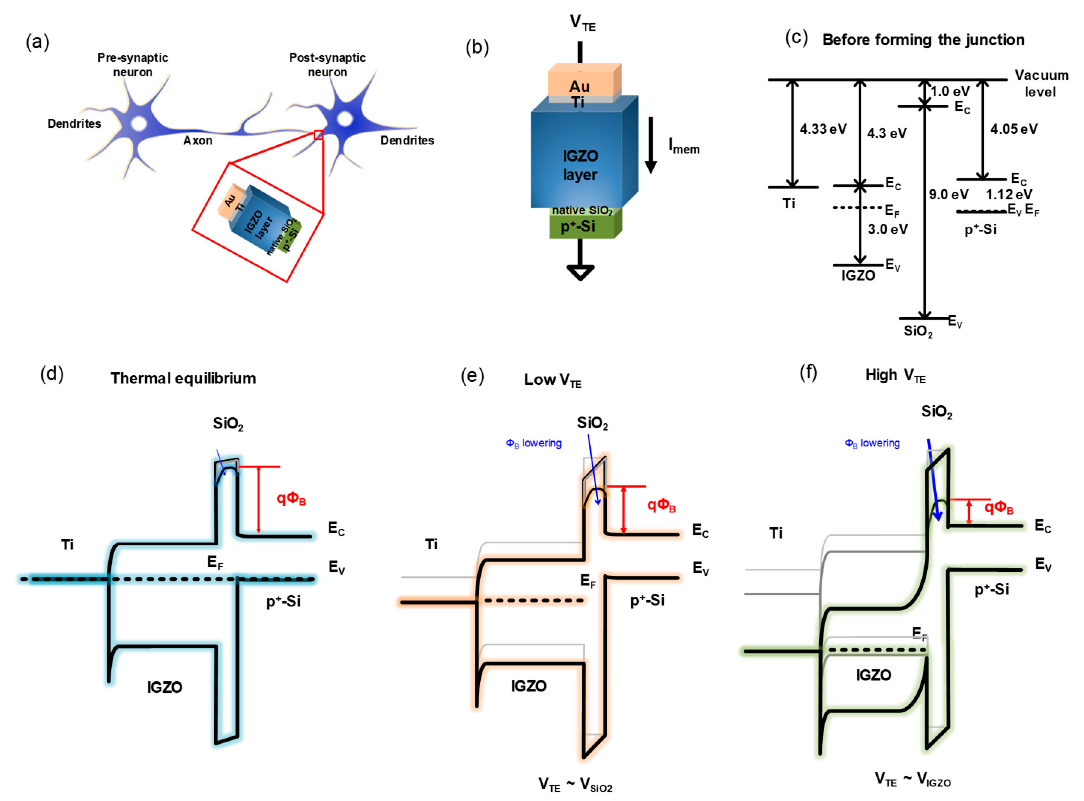
Figure 1. Schematic illustration of ( a ) the implementation of the synapse devices in bio-inspired neuromorphic computing systems and ( b ) the two-terminal Au / Ti / (amorphous indium-gallium-zinc-oxide) a-IGZO / SiO 2 / p + -Si memristors. Energy band diagram ( c ) before forming the junction, and under three conditions: ( d ) in a thermal equilibrium, ( e ) at a low (top electrode voltage) V TE , and ( f ) at a high V TE .